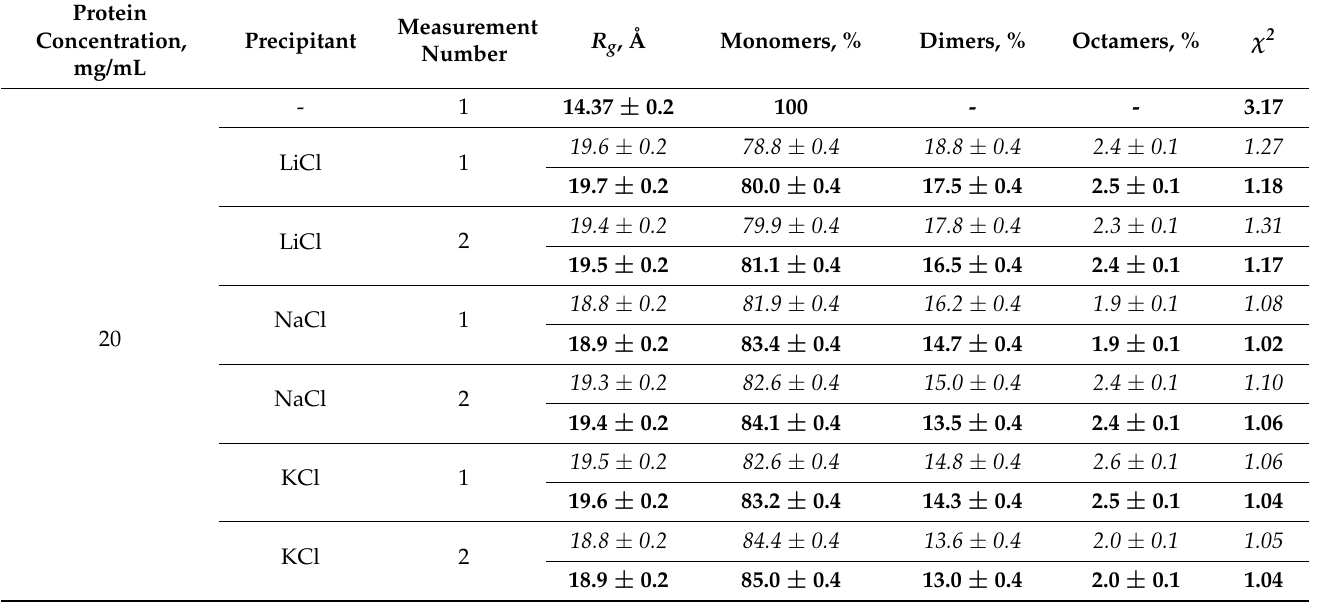
Table 1. Volume fractions of monomers and oligomers (dimers and octamers) of lysozyme in polydisperse solution with the addition of precipitants LiCl, NaCl, KCl, NiCl 2 , and CuCl 2 (salt concentration 0.4 M) at temperature 20 ◦ C and radii of gyration R g , obtained from small-angle scattering curves. The results of processing with oligomers based on structures with PDB IDs: 6QX0, 6QWY, 6QWZ, 6QWX, and 6QWW are indicated in italics, with PDB ID: 4WLD—bold. For each precipitant, the data from two independent measurements (1 and 2) are presented. The percentage of tetramers and hexamers is 0% and is not given in the